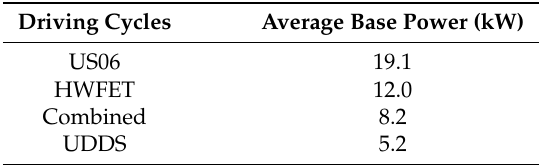
Table 6. Average power in the studied driving